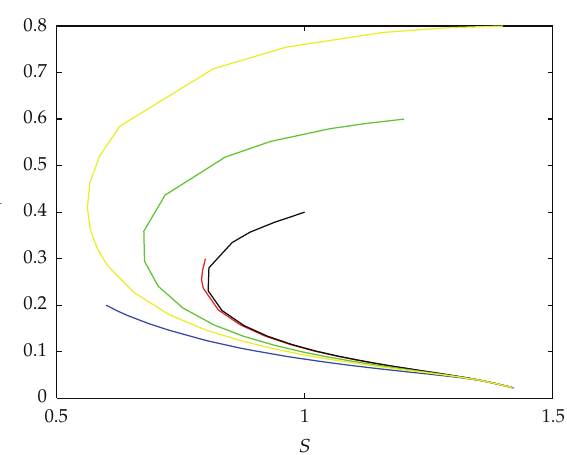
Figure 6: Phase diagram of S (cid:3) t (cid:4) with di ff erent initial values and parameters ρ (cid:7) 0 . 3 , μ (cid:7) 0 . 2 , β (cid:7) 1 . 5 , α (cid:7) 1 , r (cid:7) 0 . 5 , d (cid:7) 0 . 2 , ω (cid:7) 0 . 1 , and τ (cid:7) 0 . 5.